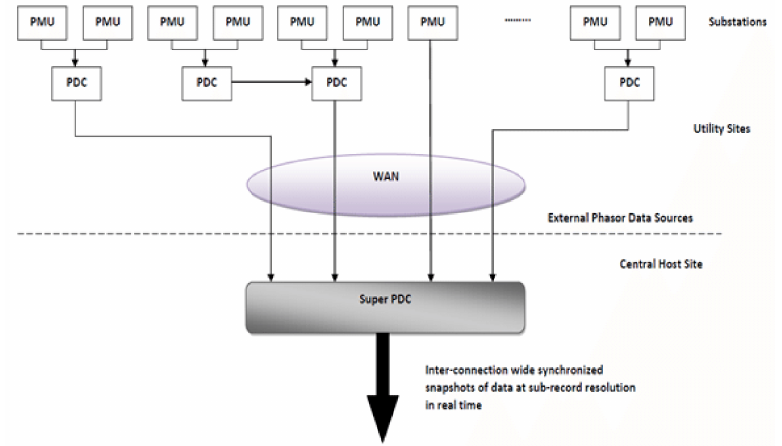
Figure 2. Wide-area measurement system